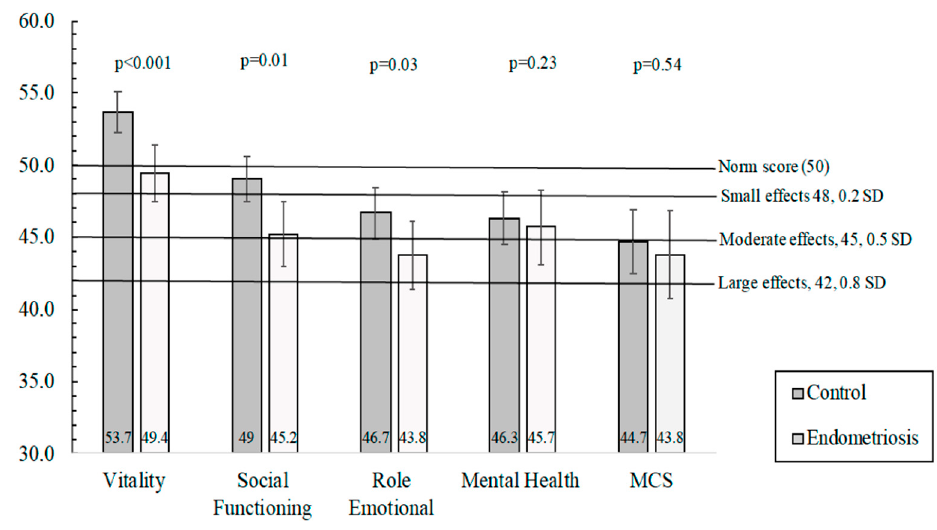
Figure 2. Adjusted means and 95% CI of the four scales and Mental Component Summary (MCS) of the SF-12v2 questionnaire. Model adjusted by age, educational level, marital status, infertility problems and current occupation (ANCOVA).